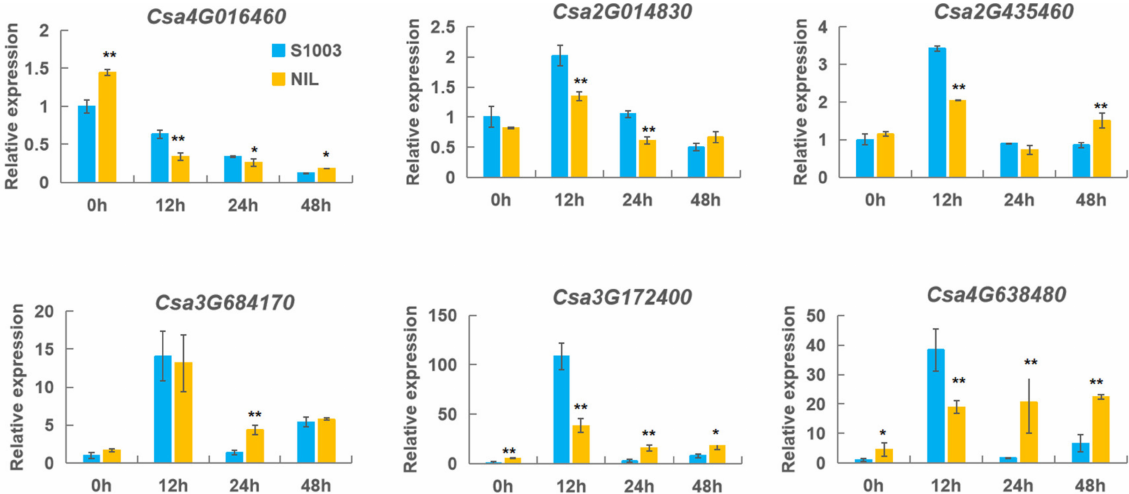
Figure 8. The expression patterns of the CNL genes responding to PM in cucumber plants. The expression levels of the CNL genes were detected in S1003 and NIL( Pm5.1 ) for 0 h, 12 h, 24 h, and 48 h after inoculation. S1003, resistance cucumber inbred line; NIL, and susceptible cucumber inbred line NIL( Pm5.1 ). The expression level of transcript at 0 h was set to a value of ‘1’. Values are mean ± SE (n = 3) (* and ** indicate significant differences between S1003 and NIL( Pm5.1 ) at p = 0.01 and 0.05,